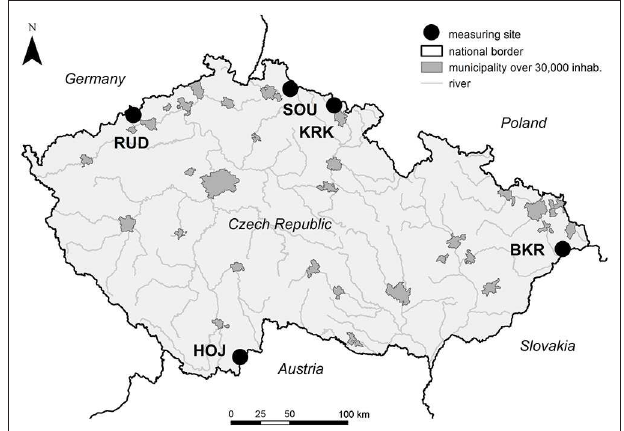
FIGURE 1 | Measuring sites in map (the map was created in ArcGIS 10.3, based on ZABAGED layers, i.e., the geographic base data of the Czech Republic, belonging to information systems of the public